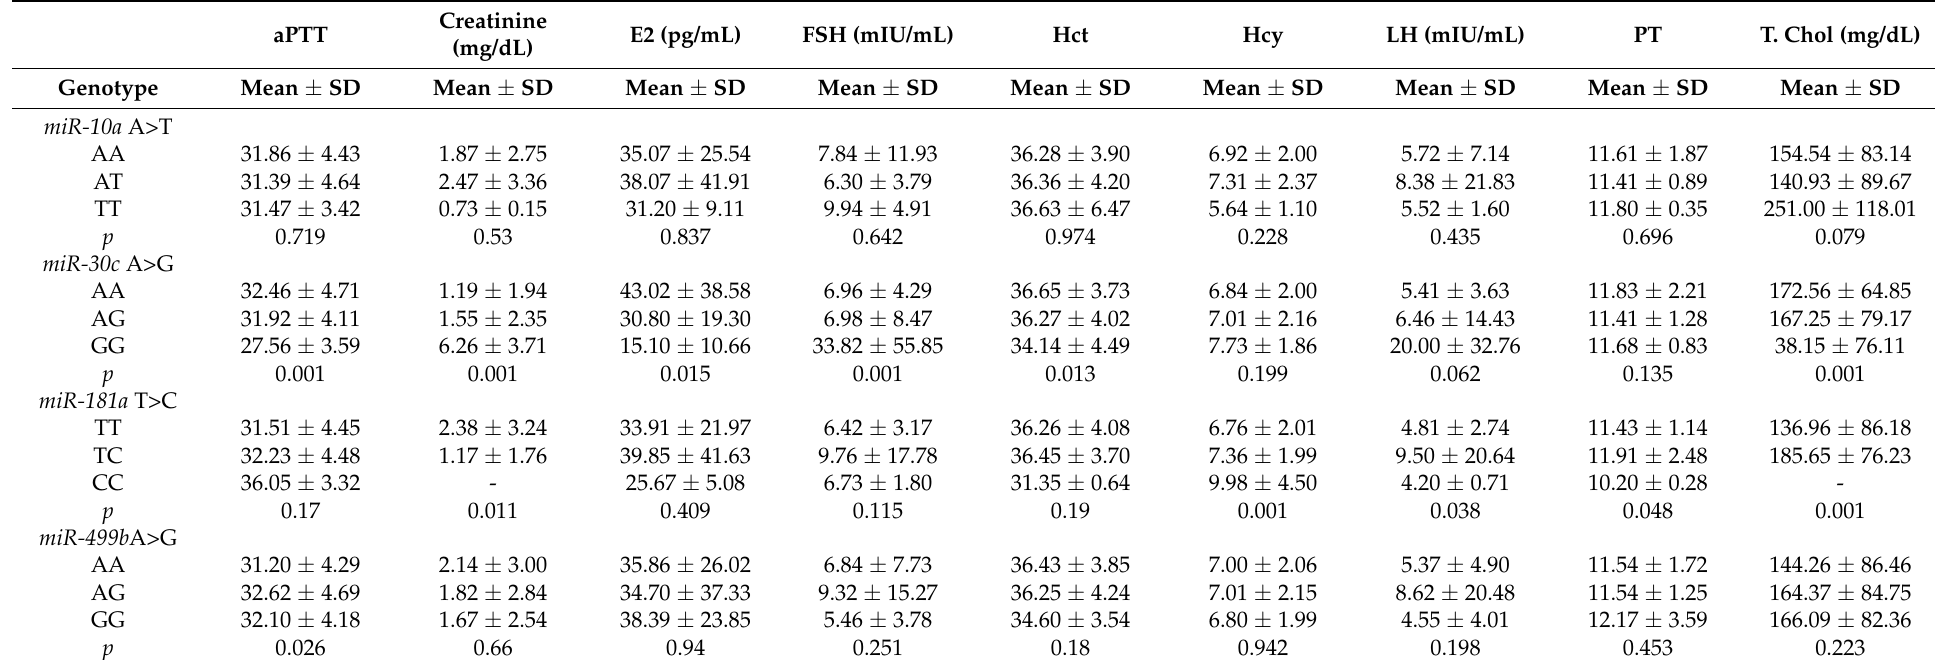
Table 6. Differences of various clinical parameters according to miRNA polymorphisms in RPL